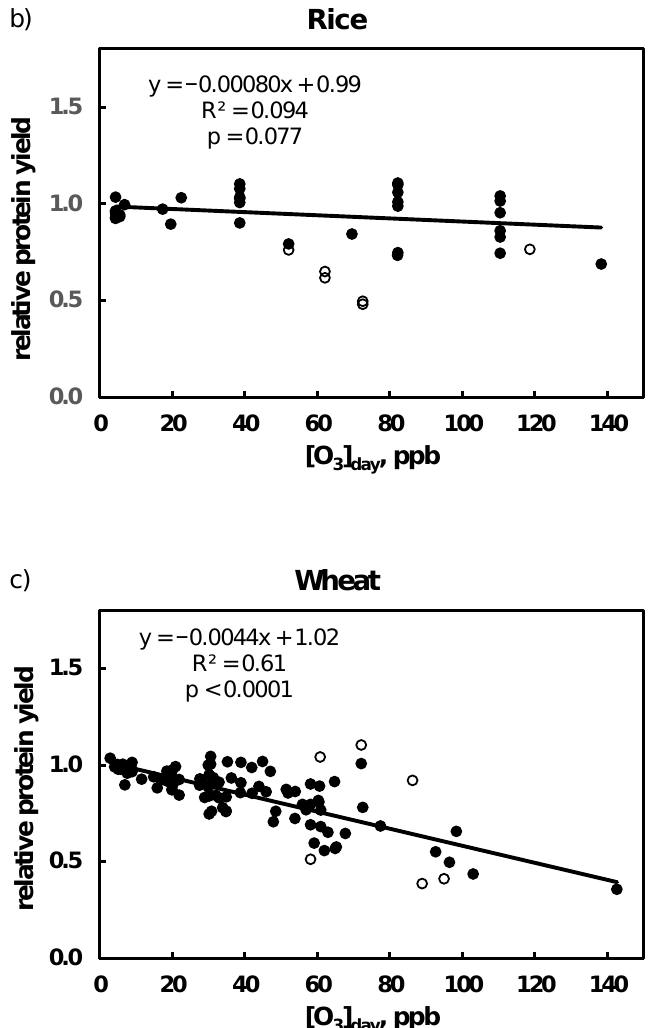
Figure 3. Relationship between relative seed protein yield (SPY) and daytime O 3 concentration, [O 3 ] day , for ( a ) soybean; ( b ) rice; ( c ) wheat. Open circles denote data points representing statistical outliers for at least one of the studied response variables.